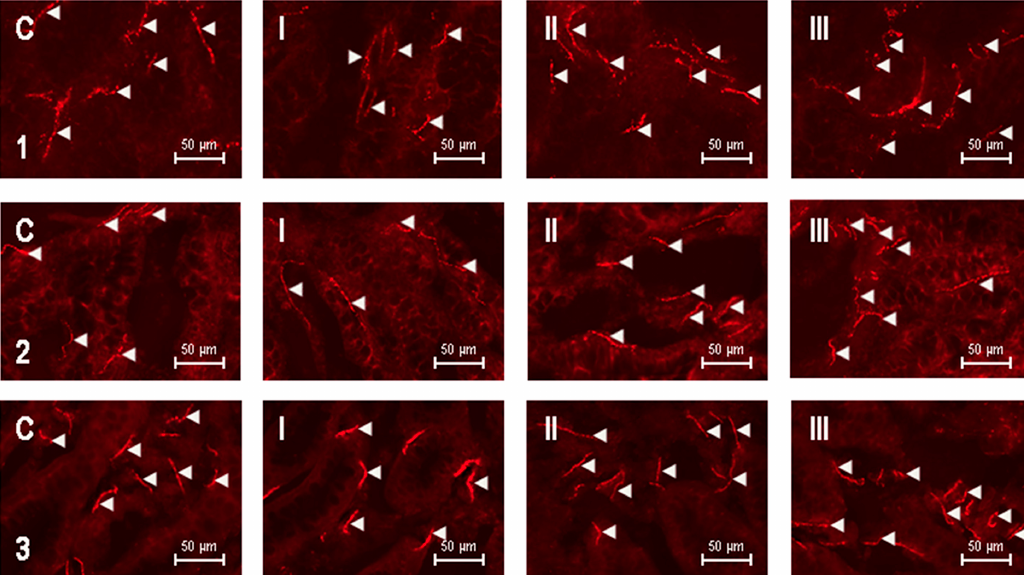
B—significantly di ff erent from group I, C—significantly di ff erent from group II and D—significantly di ff erent from group III. Kruskal-Wallis test: p < 0.05—lowercase letters and p < 0.01—uppercase letters.